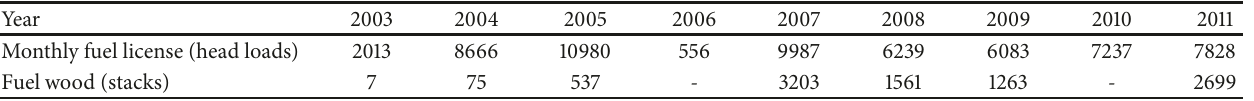
Table 1: Sale of minor forest produce in Kirinyaga from 2003-2011.